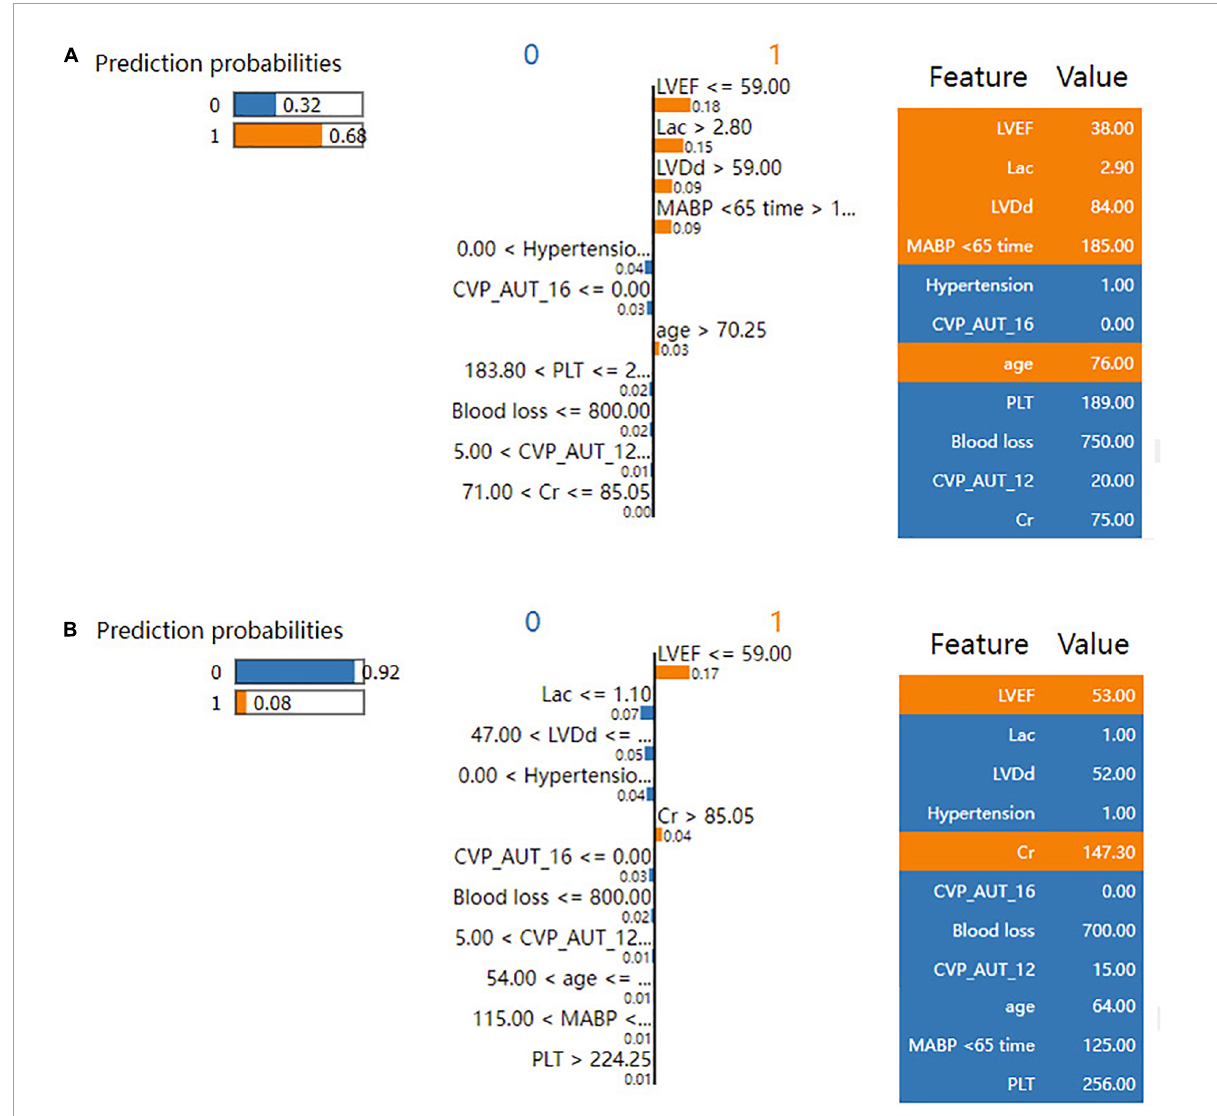
FIGURE5 LIME plot for individual case explanation on two random patients for the test set of the reduced RF model. LIME plot included one patient with LCOS (A) and one patient without LCOS (B) , explained by LIME algorithm. ECHO, echocardiography; LVDd, left ventricular diastolic diameter; LVPWT, left ventricular posterior wall thickness; LVEF, left ventricular ejection fraction; WBC, white blood cell count; NEU, neutrophil properties; Cr, blood creatinine; BUN, blood urea nitrogen; AST, aspartate aminotransferase; Lac, blood lactate; CPB, cardiopulmonary bypass; AO, aortic occlusion; CABG, coronary artery bypass graft; MABP < 65 time, cumulative time of mean artery blood pressure lower than 65 mmHg; MABP < 60 time, cumulative time of mean artery blood pressure lower than 60 mmHg; MABP < 55 time, cumulative time of mean artery blood pressure lower than 55 mmHg; MABP < 50 time, cumulative time of mean artery blood pressure lower than 50 mmHg; MABP_AUT_65, total area under curve below threshold mean artery blood pressure 65 mmHg; MABP_AUT_60, total area under curve below threshold mean artery blood pressure 60 mmHg; MABP_AUT_55, total area under curve below threshold mean artery blood pressure 55 mmHg; MABP_AUT_50, total area under curve below threshold mean artery blood pressure 50 mmHg; MABP_TWA_65, time weighted average mean artery blood pressure below threshold 65 mmHg; MABP_TWA_60, time weighted average mean artery blood pressure below threshold 60 mmHg; MABP_TWA_55, time weighted average mean artery blood pressure below threshold 55 mmHg; MABP_TWA_50, time weighted average mean artery blood pressure below threshold 50 mmHg; CVP > 12 time, cumulative time of central venous pressure upper than 12 mmHg; CVP > 16 time, cumulative time of central venous pressure upper than 16 mmHg; CVP > 20 time, cumulative time of central venous pressure upper than 20 mmHg; CVP_AUT_12, total area under curve above threshold central venous pressure 12 mmHg; CVP_AUT_16, total area under curve above threshold central venous pressure 16 mmHg; CVP_AUT_20, total area under curve above threshold central venous pressure 20 mmHg; CVP_TWA_12, time weighted average central venous pressure above threshold 12 mmHg; CVP_TWA_16, time weighted average central venous pressure above threshold 16 mmHg; CVP_TWA_20, time weighted average central venous pressure above threshold 20 mmHg; LCOS, low cardiac output